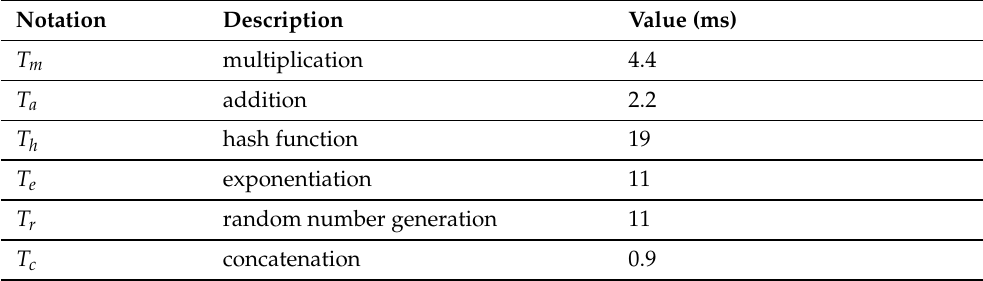
Table 3. The used notations with runtimes.